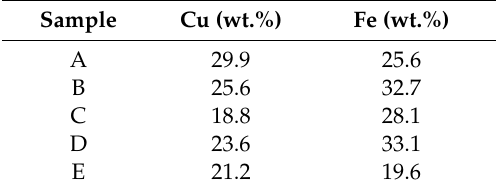
Table 1. Chemical analyses of the chalcopyrite samples.